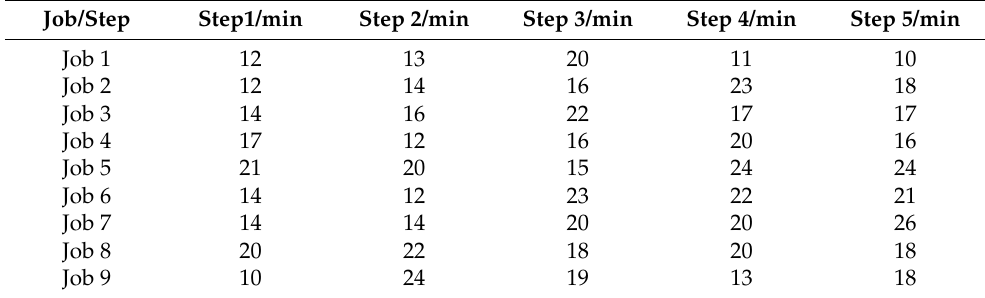
Table 1. Job verification time of each step.